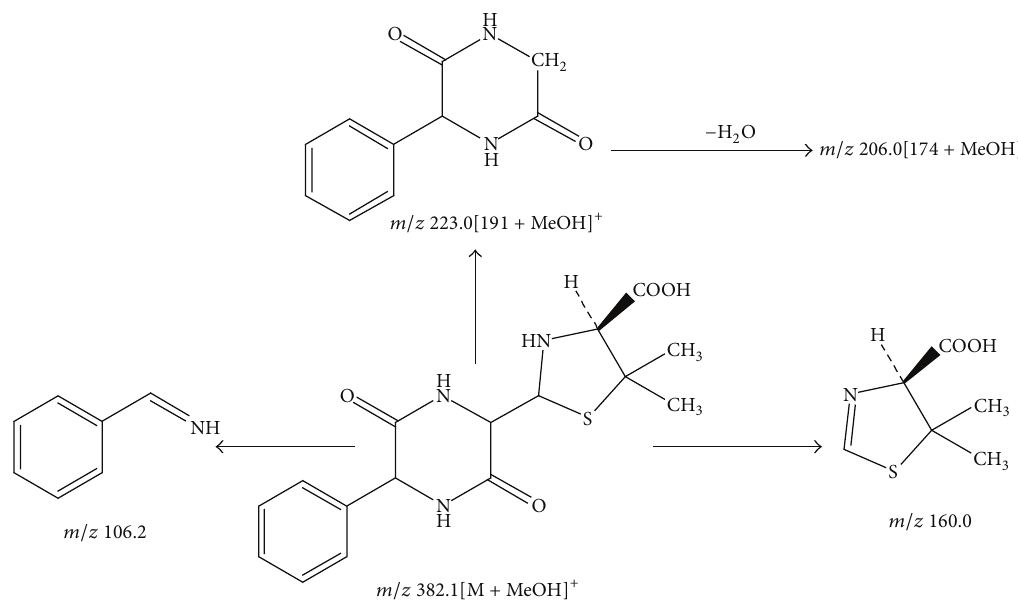
Figure 7: Proposed fragmentation pathway for the fragmentation ion of diketopiperazines of ampicillin.